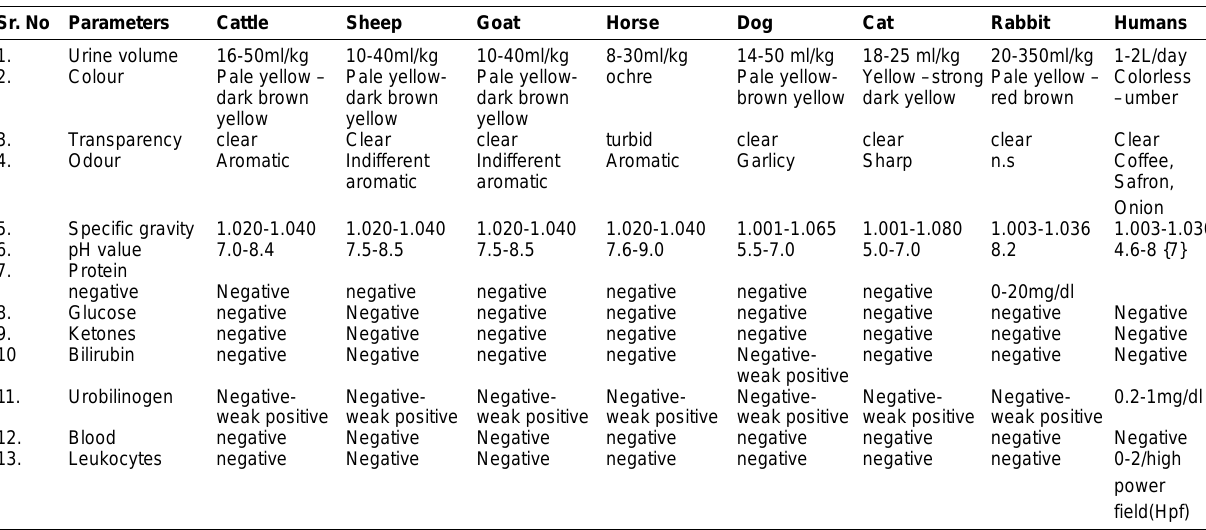
Table-1. Reference values for various urinary parameters in different species [6,39] Sr. No